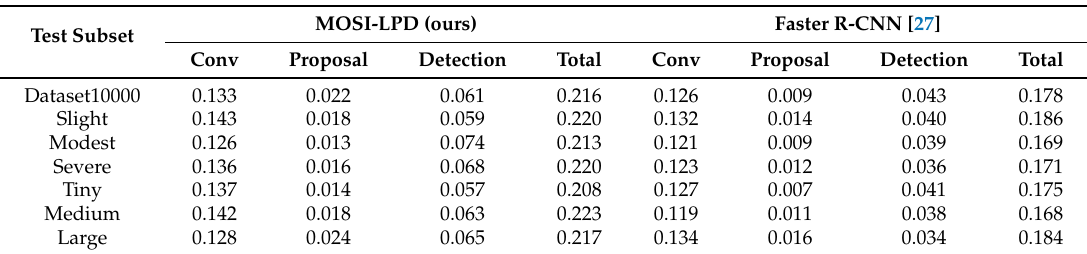
Table 5. The average time costs of our MOSI-LPD and backbone framework Faster R-CNN [27] on various test subsets (unit: second). MOSI-LPD (ours) Faster R-CNN [27] Test Subset Conv Proposal Detection Conv Proposal